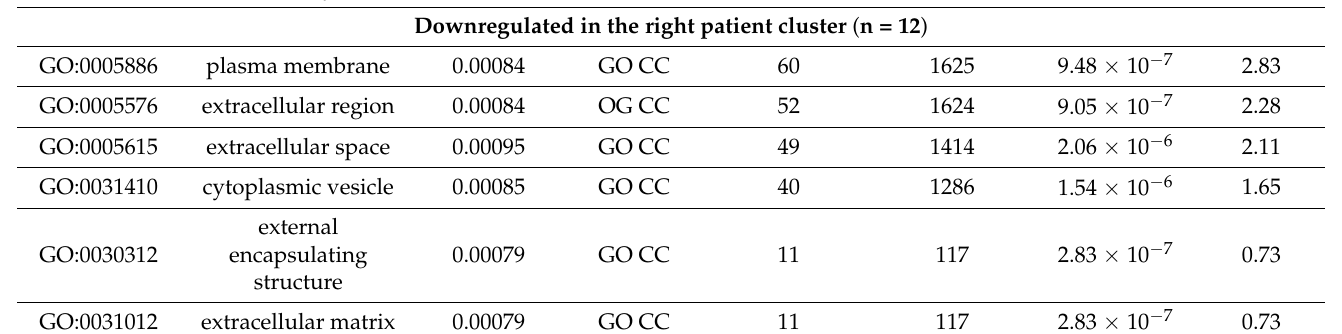
Abbreviations: CC, cellular component; MF, molecular function; Uniprot, Uniprot